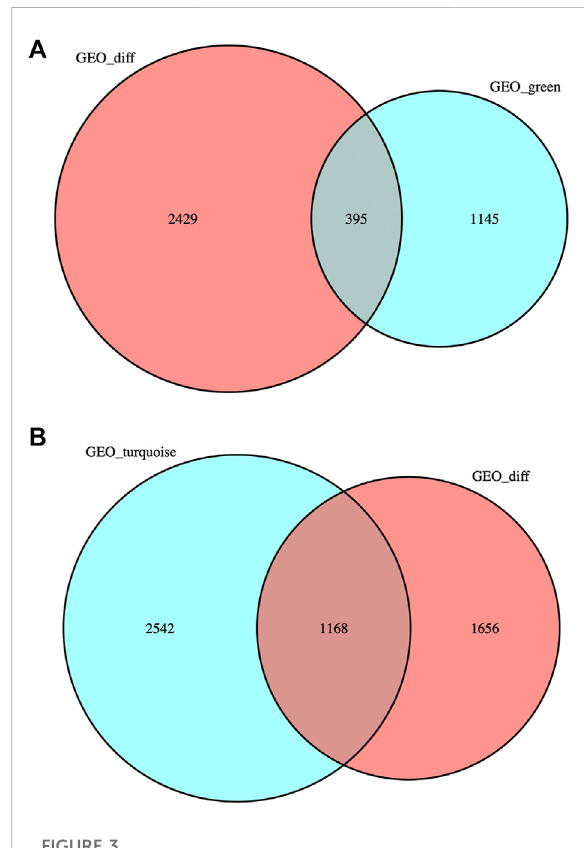
FIGURE 3 Venn diagrams. (A) DEG was intersected with the genes in MEgreen module: 395 genes were obtained. (B) DEG was intersected with the genes in MEturquoise module: 1,168 genes were